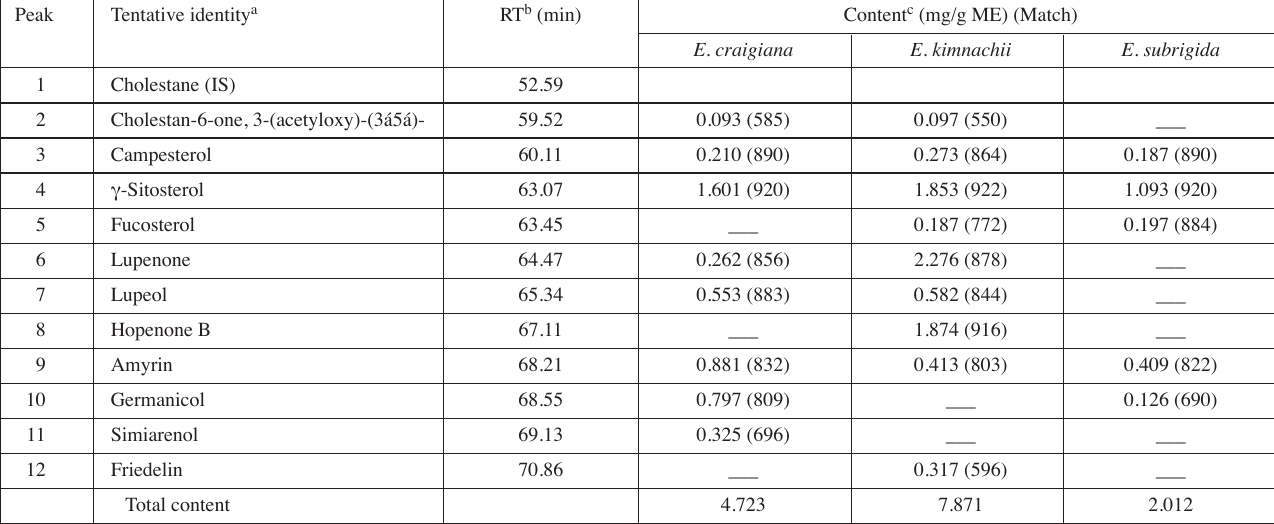
Tab. 1: Terpenes/sterols profile (GC-MS) of Echeveria methanol extracts (ME) Peak